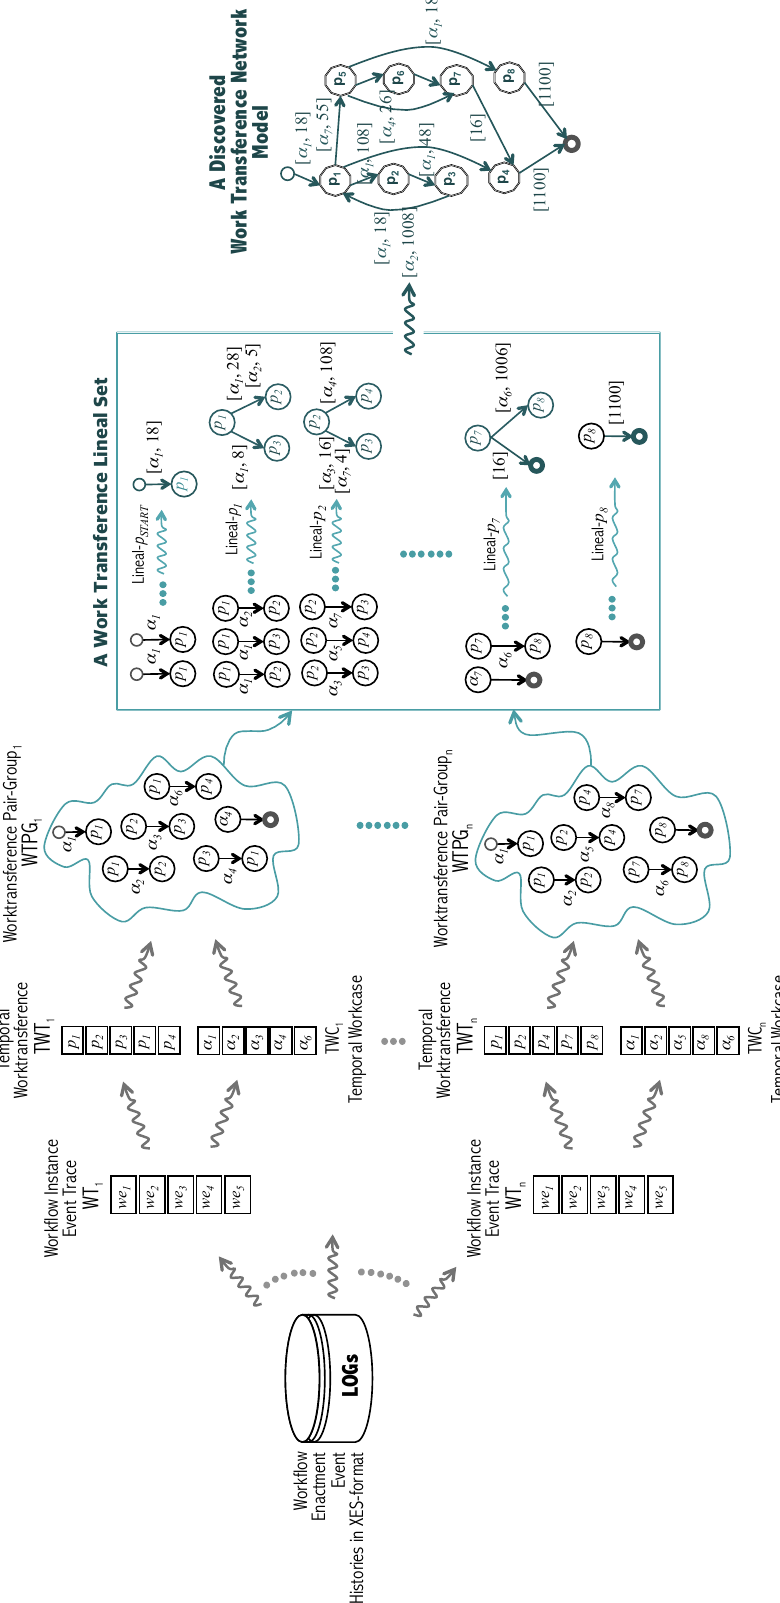
Figure 4. Concrete discovery